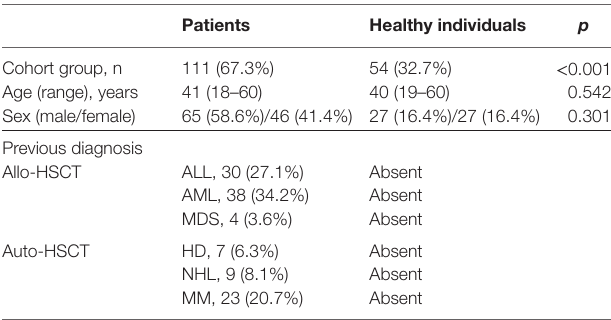
Table 1 | Characteristics of patients and healthy